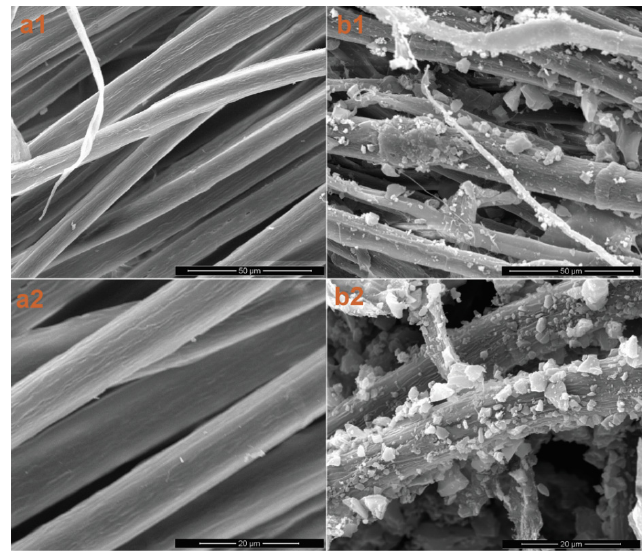
Figure 2. SEM observation of the un ‐ treated fiber ( a1 , a2 ); and Fiber/PAC30 ( b1 , b2 ). Table 1. Contents of PAC loaded fibers.